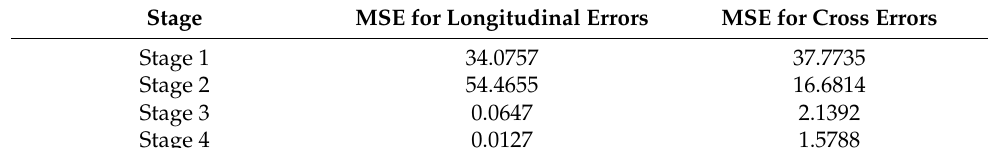
Table 3. Path-following and obstacle avoidance controller performance at different training stages.